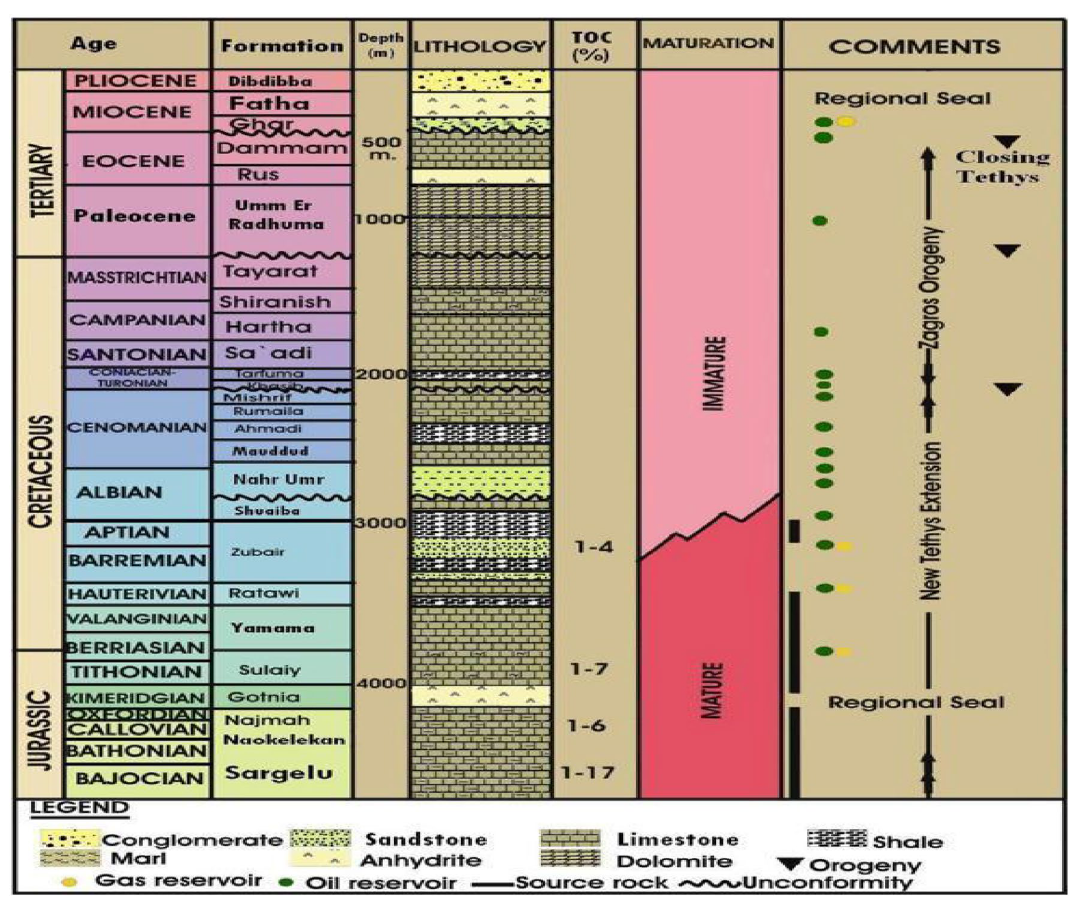
Fig. 2 Stratigraphic column of the Rumaila field (Al-Ameri et al.